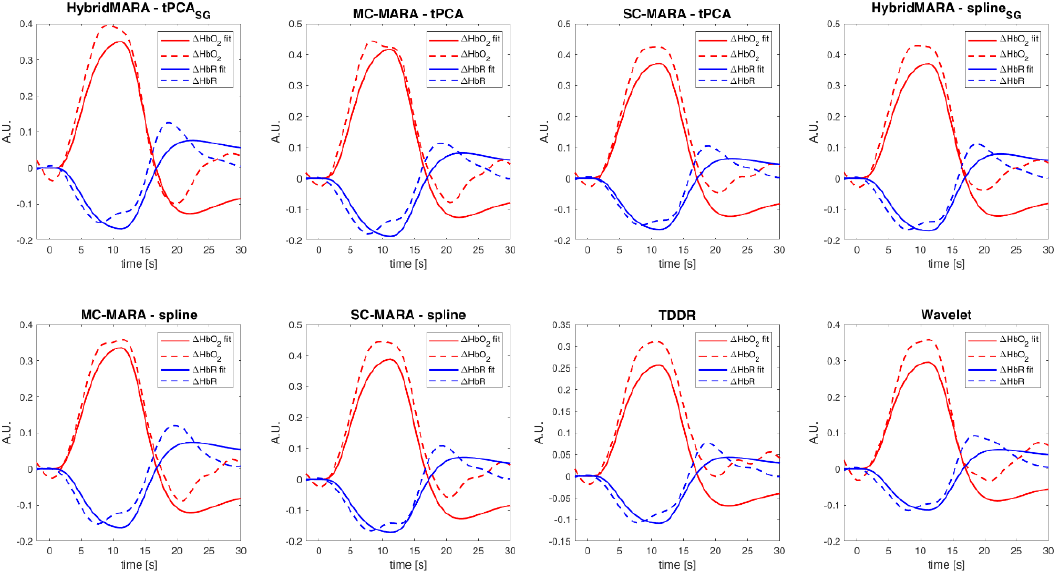
Figure 9. Visual comparison of subject-specific block-averaged response (dashed line) and GLM fitting (bold line) across pipelines. These results are related to left-hand motor grasp and a measurement channel placed over the right motor region (i.e., contralateral hemisphere) in accordance with Figure 7.